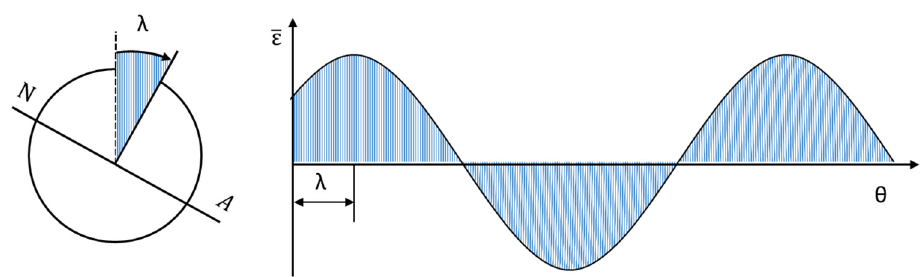
Figure 4. Typical angle-domain shaft strain curve.